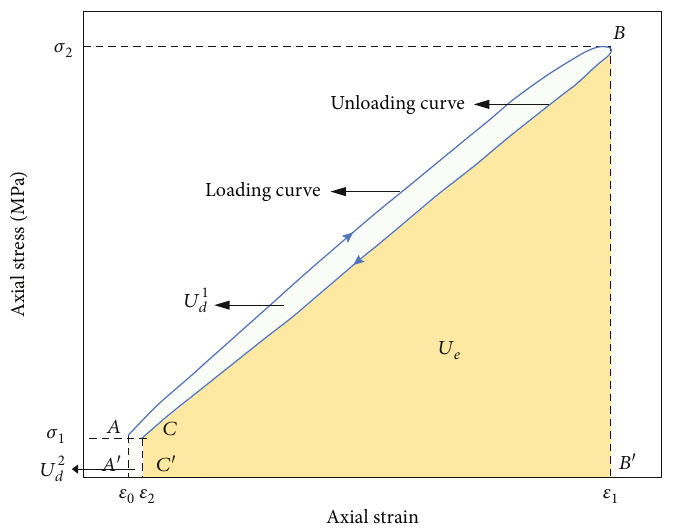
Figure 11: Hysteresis loop of rock under cyclical loading and unloading